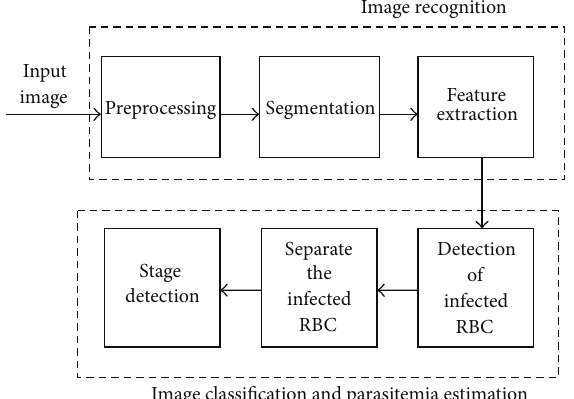
Figure 1: Block diagram of the proposed method.